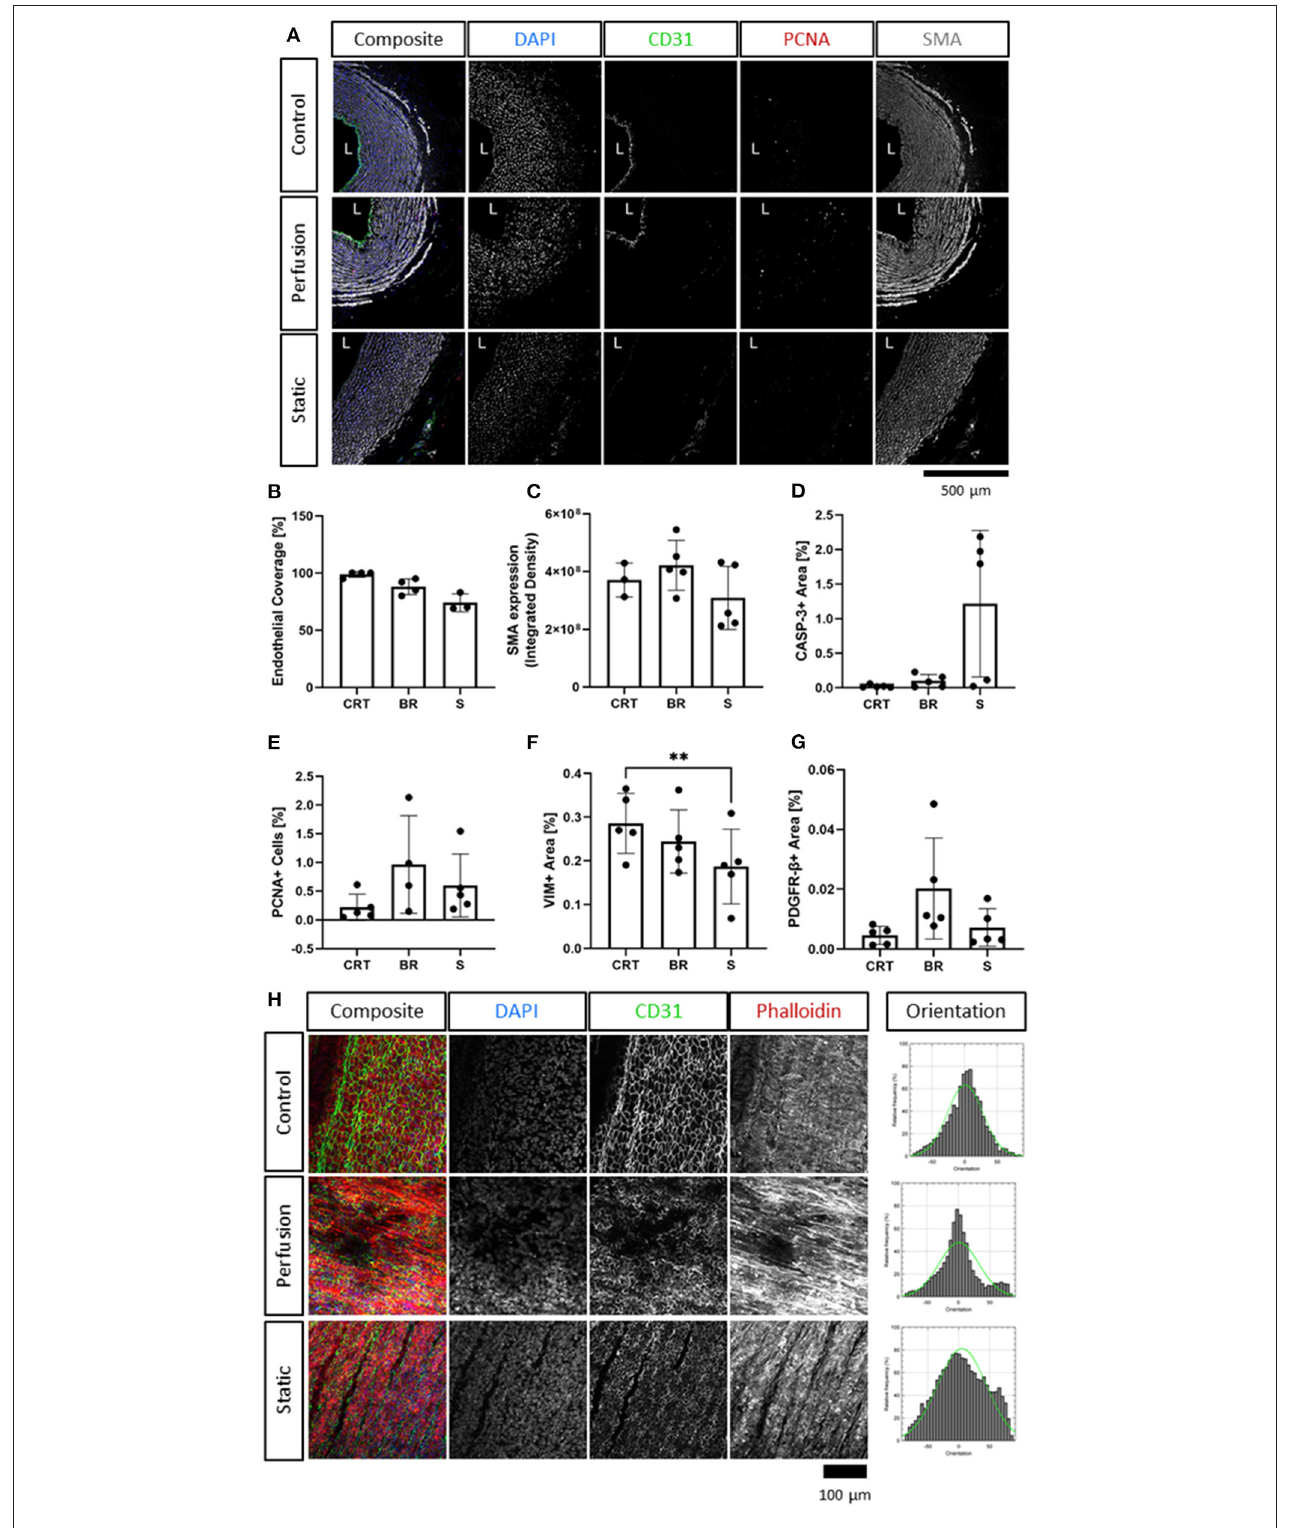
FIGURE 3 | Immunofluorescence analysis of cultured carotid arteries indicates better tissue preservation in flow. Immunofluorescence staining of freshly isolated arteries (d0, Control/CRT), EasyFlow (Perfusion/BR) and static cultured arteries (Static/S) at day 7, showing expression of endothelial marker CD31, smooth